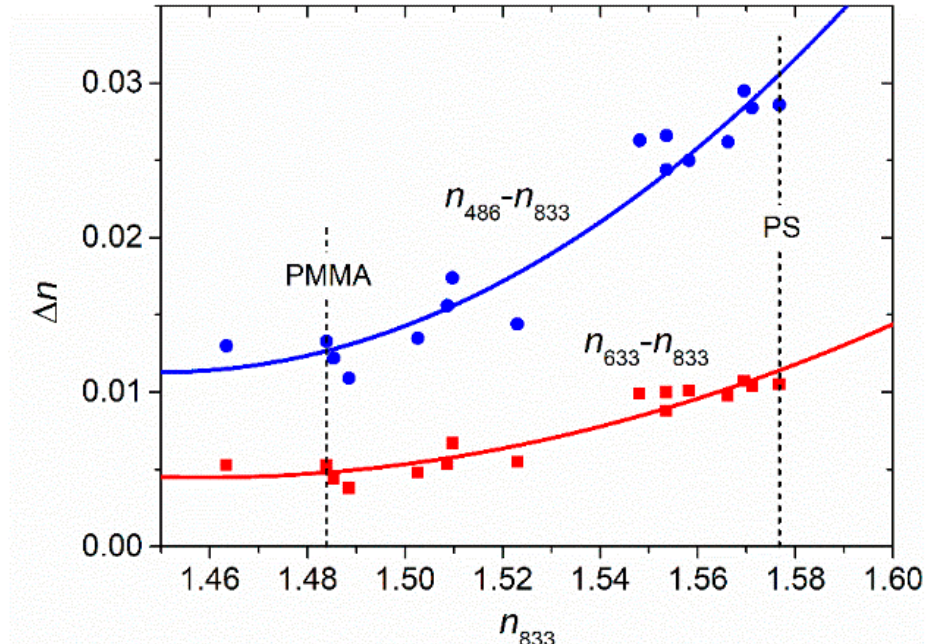
Figure 1. Partial dispersions n for a series of (cid:31) Ps ( n data taken from ref. [12]) fitted (solid lines) with our proposed second-order polynomial model (Equation (3) for n the fits are 0.89 and 0.92, respectively).